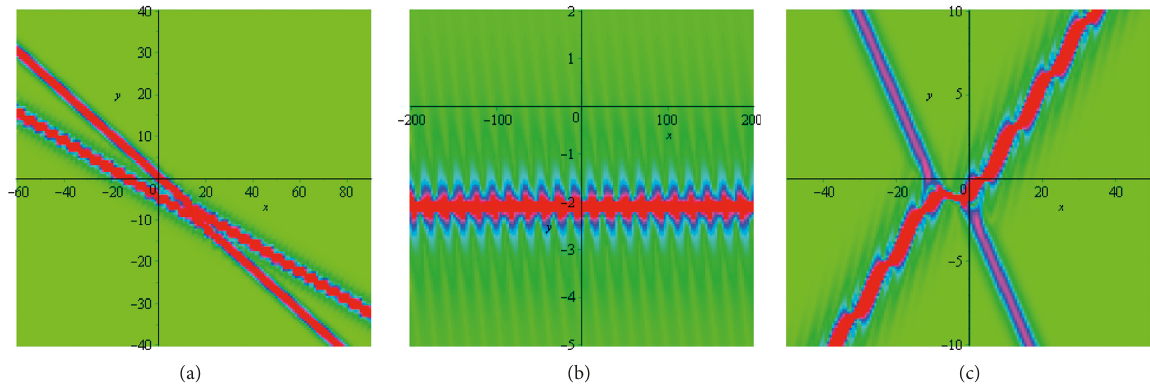
Figure 17: Plots of equation (71) by utilizing ϕ